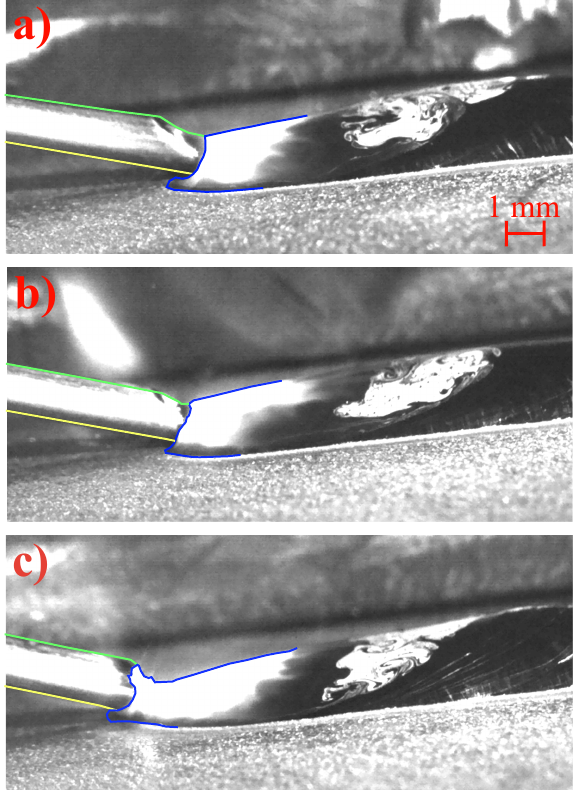
Figure 6. The wire-melt pool interaction acquired by the off-axis high-speed camera when three different levels of hot-wire and the medium laser power were applied: ( a ) L1—low hot-wire level, ( b ) L3—medium hot-wire level, ( c ) L6—high hot-wire